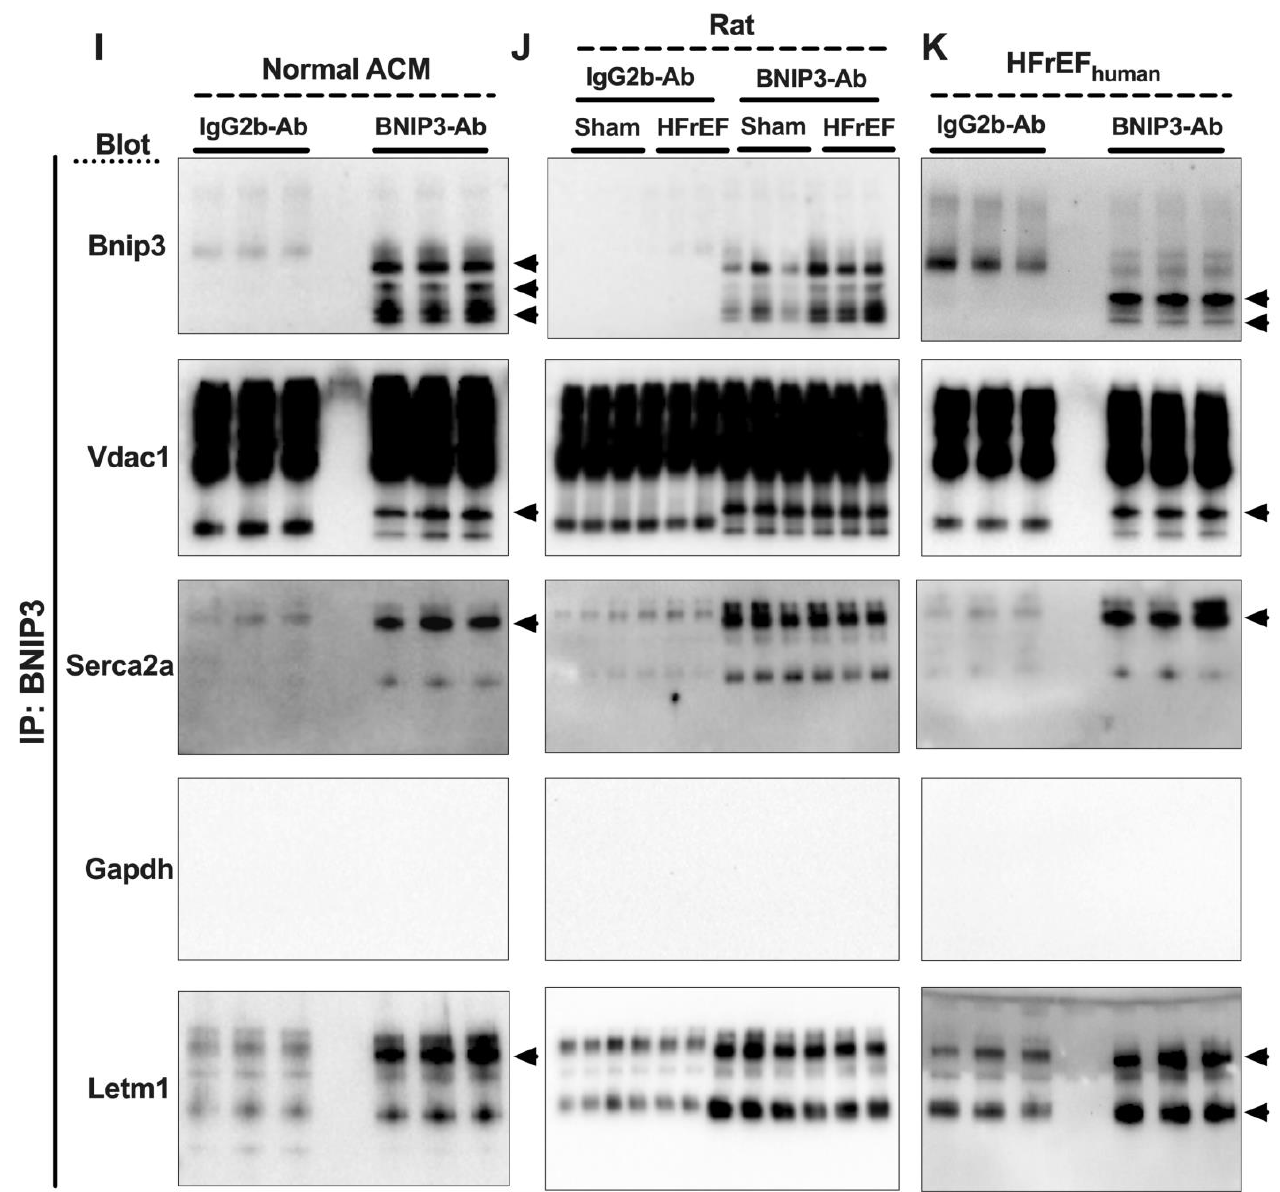
Figure 7. BNIP3 interactome in human and rat LV myocardia identified via BNIP3 co-immunoprecipitation (Co-IP) and mass spectrometry. ( A ). Venn diagrams show the total number of identified BNIP3 interacting proteins by mass spectrometry in the human (red) and rat (green) HFrEF LV myocardium. The intersection between the two Venn diagrams (black circle) shows the number of commonly identified BNIP3 interacting proteins in human and rat samples. ( B , C ) . Heat maps and PCA plots show the relative log 2 -fold expression and the variance in biological samples, respectively, in Sham and HFrEF in the rat LV myocardium of the 516 common identified BNIP3 interacting proteins (left), including those that were differentially expressed in HFrEF vs. Sham, taking a cutoff p -value of < 0.05 (right). ( D ). Heat maps show the relative log 2 -fold expression in Sham and HFrEF in the rat LV myocardium of some of the important identified BNIP3 interacting proteins that were commonly identified in rat and human HFrEF samples, presented by HFrEF vs. Sham cutoff p -value < 0.05 (left), 0.05 < p < 0.1 (middle), and p > 0.1 (right). ( E ). Western blot showing the expression of sarco/endoplasmic reticulum calcium ATPase 2a (SERCA2a) and the mt-proton/calcium exchanger protein (LETM1) in Sham, ShLuc, and ShBNIP3, * p < 0.05 vs. Sham and † p < 0.05 vs. ShLuc; m, monomer; t, trimer. ( F , G ). Heat maps of the top Canonical Pathways and Upstream Regulators that were upregulated/activated or downregulated/inhibited in HFrEF vs. Sham rat samples. The orange and blue color intensities represent the z-score-based ex-